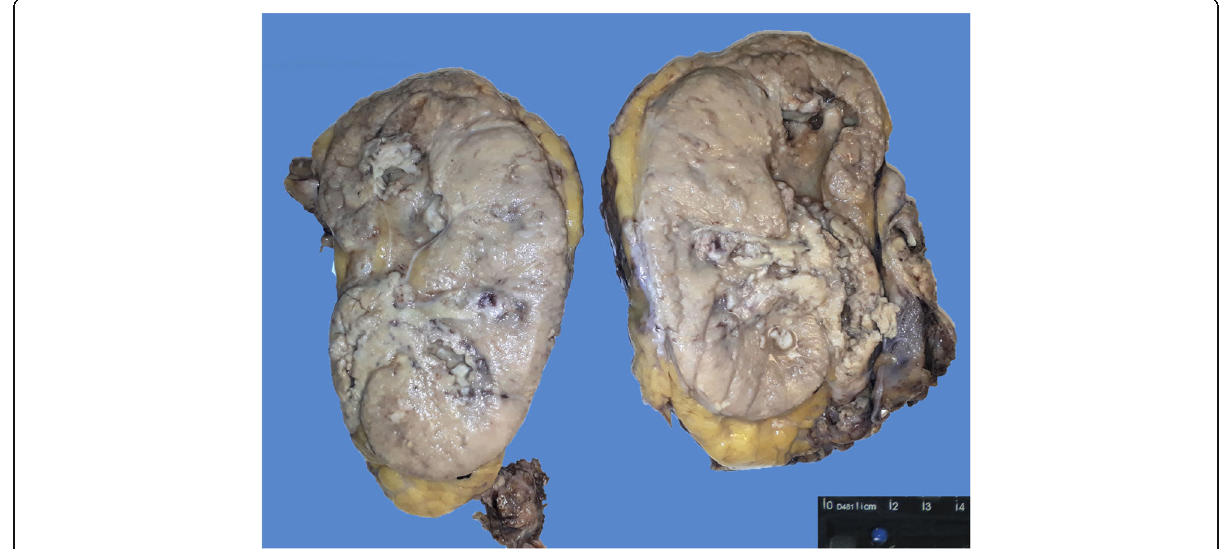
Fig. 2 Gross image of the resected kidney, demonstrating a distorted renal parenchyma with a friable lesion in the pyelo-calix, medulla and